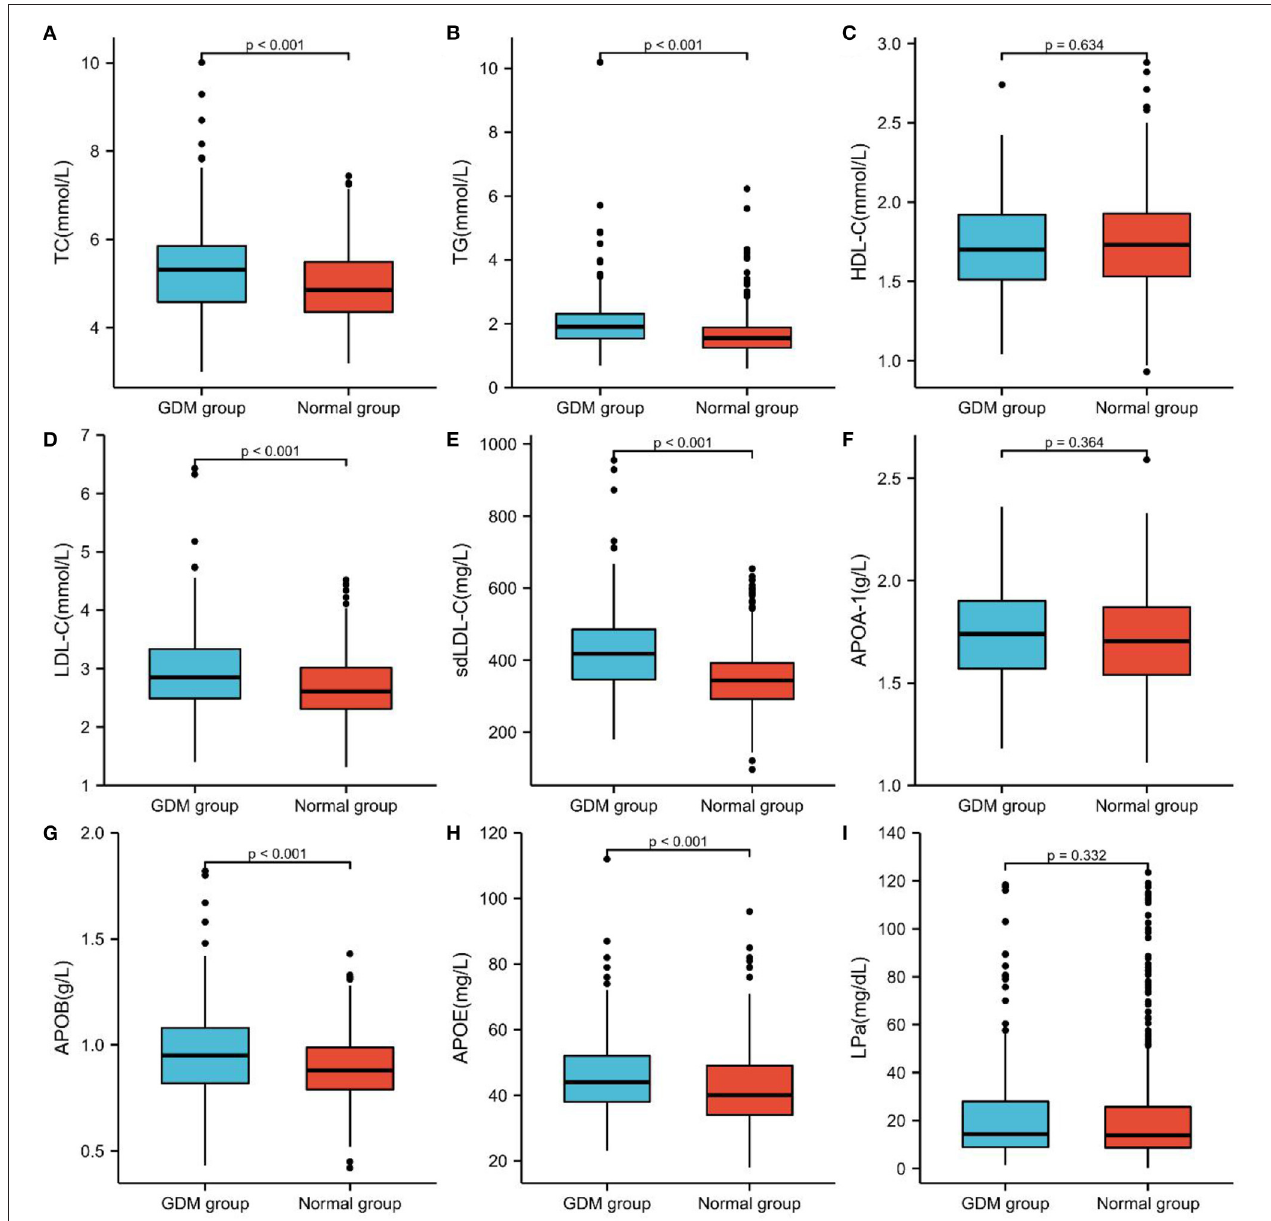
FIGURE 2 | Comparison of blood lipid and lipoprotein profiles of the two groups in pregnant women with GDM and non-GDM. (A) TC, (B) TG, (C) HDL-C, (D) LDL-C, (E) sd LDL-C, (F) APOA-1, (G) APOB, (H) APOE, (I) LPa.